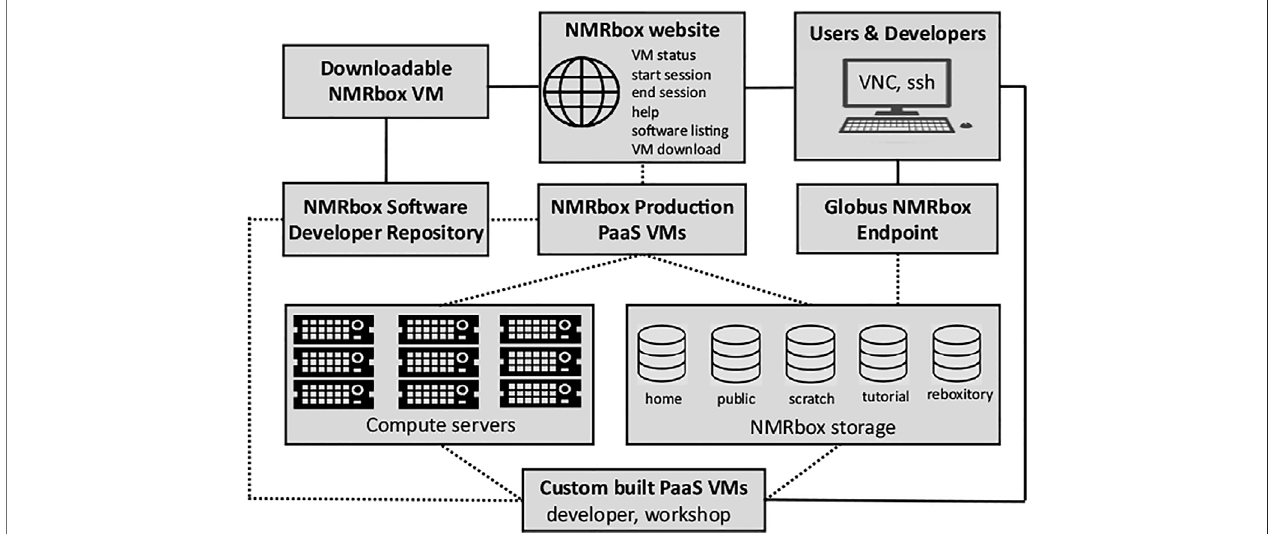
FIGURE 2 | Schematic representation of the NMRbox platform from an end-user and software developer perspective. Solid lines illustrate direct services available to users and developers, while dotted lines represent services that are available transparently through connections controlled by the NMRbox infrastructure. Users connect to NMRbox PaaS VMs (production or custom built) through VNC which provides a full GUI desktop environment or ssh for a command-line interface. The NMRbox website provides users the ability to check the status of VMs, start and end VNC sessions, help documentation, and a complete software listing with version information. File transfers are performed via ssh (scp/sftp) or the NMRbox Globus institutional endpoint. All NMRbox VMs (production, custom, and downloadable) are provisioned with software from the NMRbox software developer repository. All PaaS VMs are backed by signi fi cant computational resources and storage appliances in the HPC